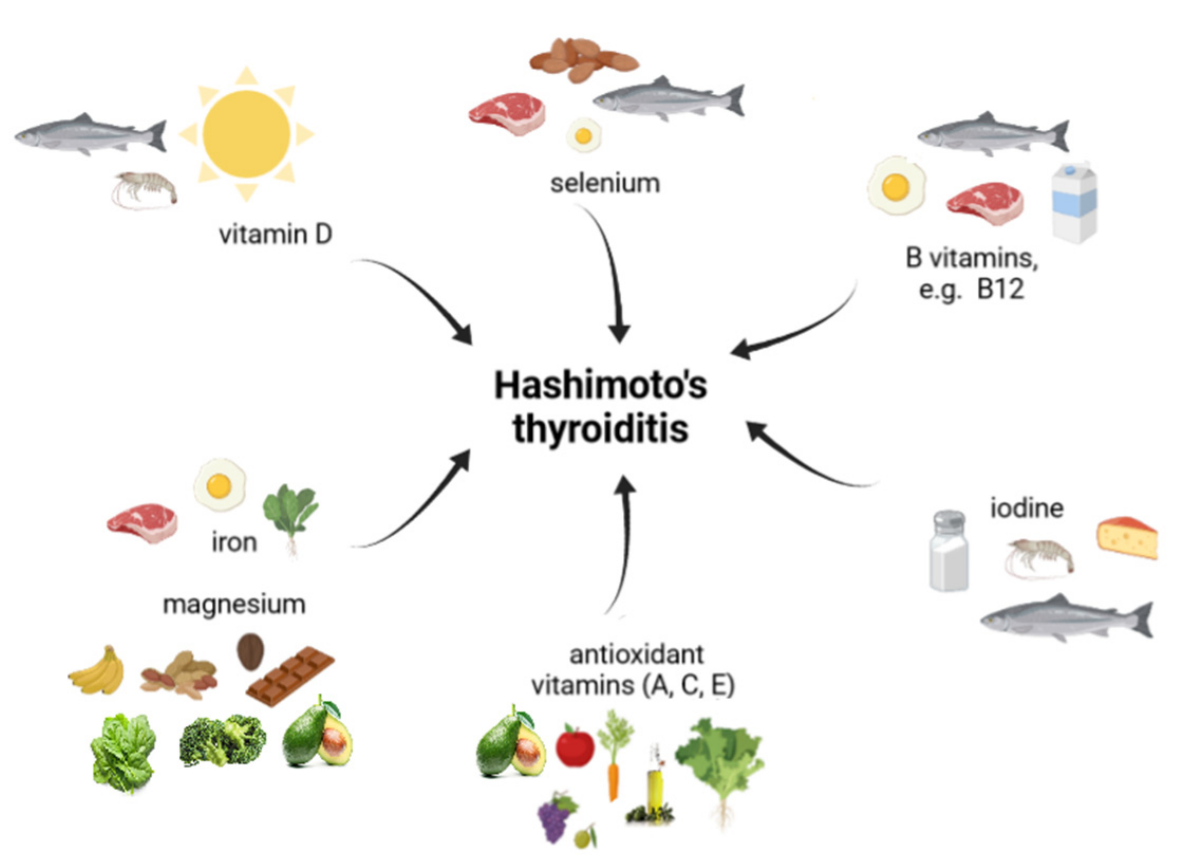
Figure 2. Important nutritional microelements in Hashimoto’s thyroiditis.